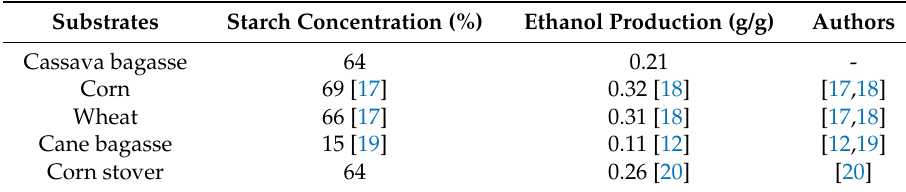
Table 4. Potential of ethanol production from different substrates.